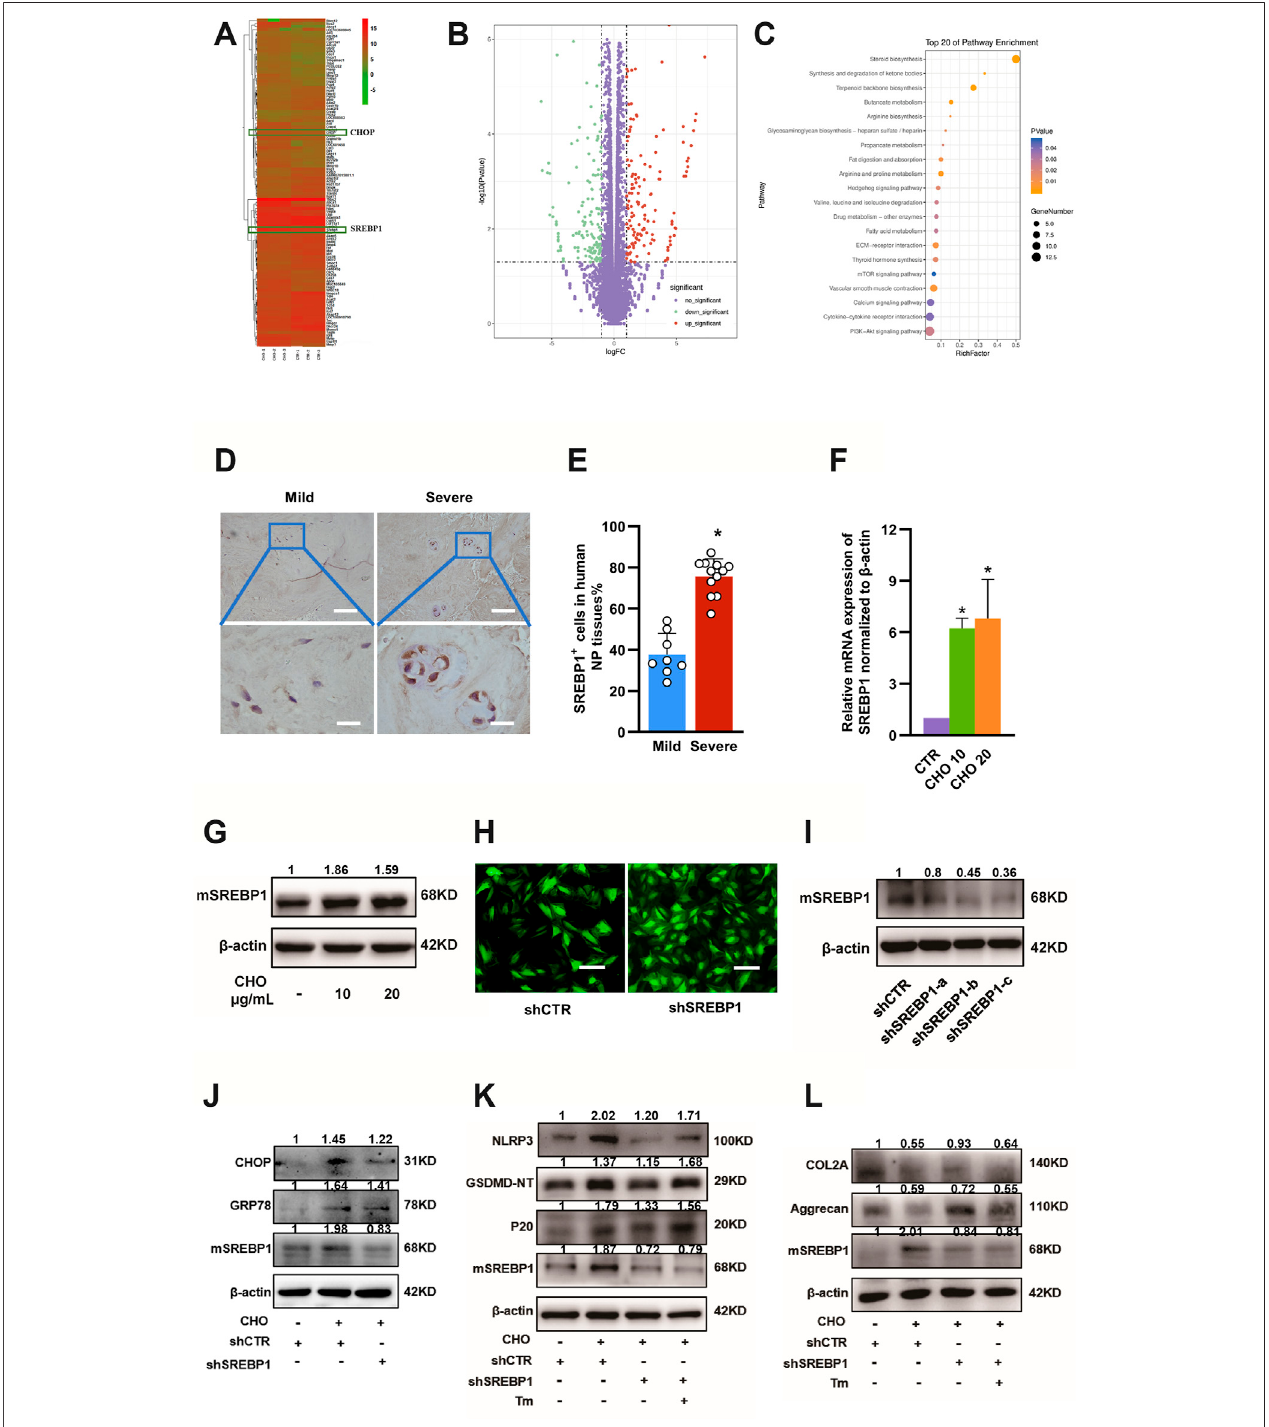
FIGURE6| SREBP1maturationisrequiredforcholesterol-inducedERstressinIDD. (A,B) Microarrayanalysis(heatmapsandvolcanoplot)ofgeneexpressionsof rat NP cells treated with PBS and 10 μ g/ml cholesterol is shown. (C) Pathway changes in NP cells. (D) Representative images of SREBP1 staining in mild and severe degenerative NPtissues, asdetermined byIHC (upper panel, bar (cid:1) 100 μ m; lower panel, bar (cid:1) 20 μ m). (E) Quanti fi cation ofpositivecells showing increased expression ofSREBP1inseveredegenerativeNPtissues(n (cid:1) 8 – 12) (F) RT-qPCRanalysisofthemRNAlevelsofSREBP1showedasigni fi cantincreaseinNPcellstreatedwith cholesterol (n (cid:1) 3). (G) Protein expression levels of mSREBP1 were upregulated by cholesterol stimulation, as determined by immunoblotting (H) Immuno fl uorescence images of NP cells transfected with LV-shCTR and LV-SREBP1 (bar (cid:1) 100 μ m). (I) Rat NP cells were transfected with lentiviral vectors containing shRNA-SREBP1 and